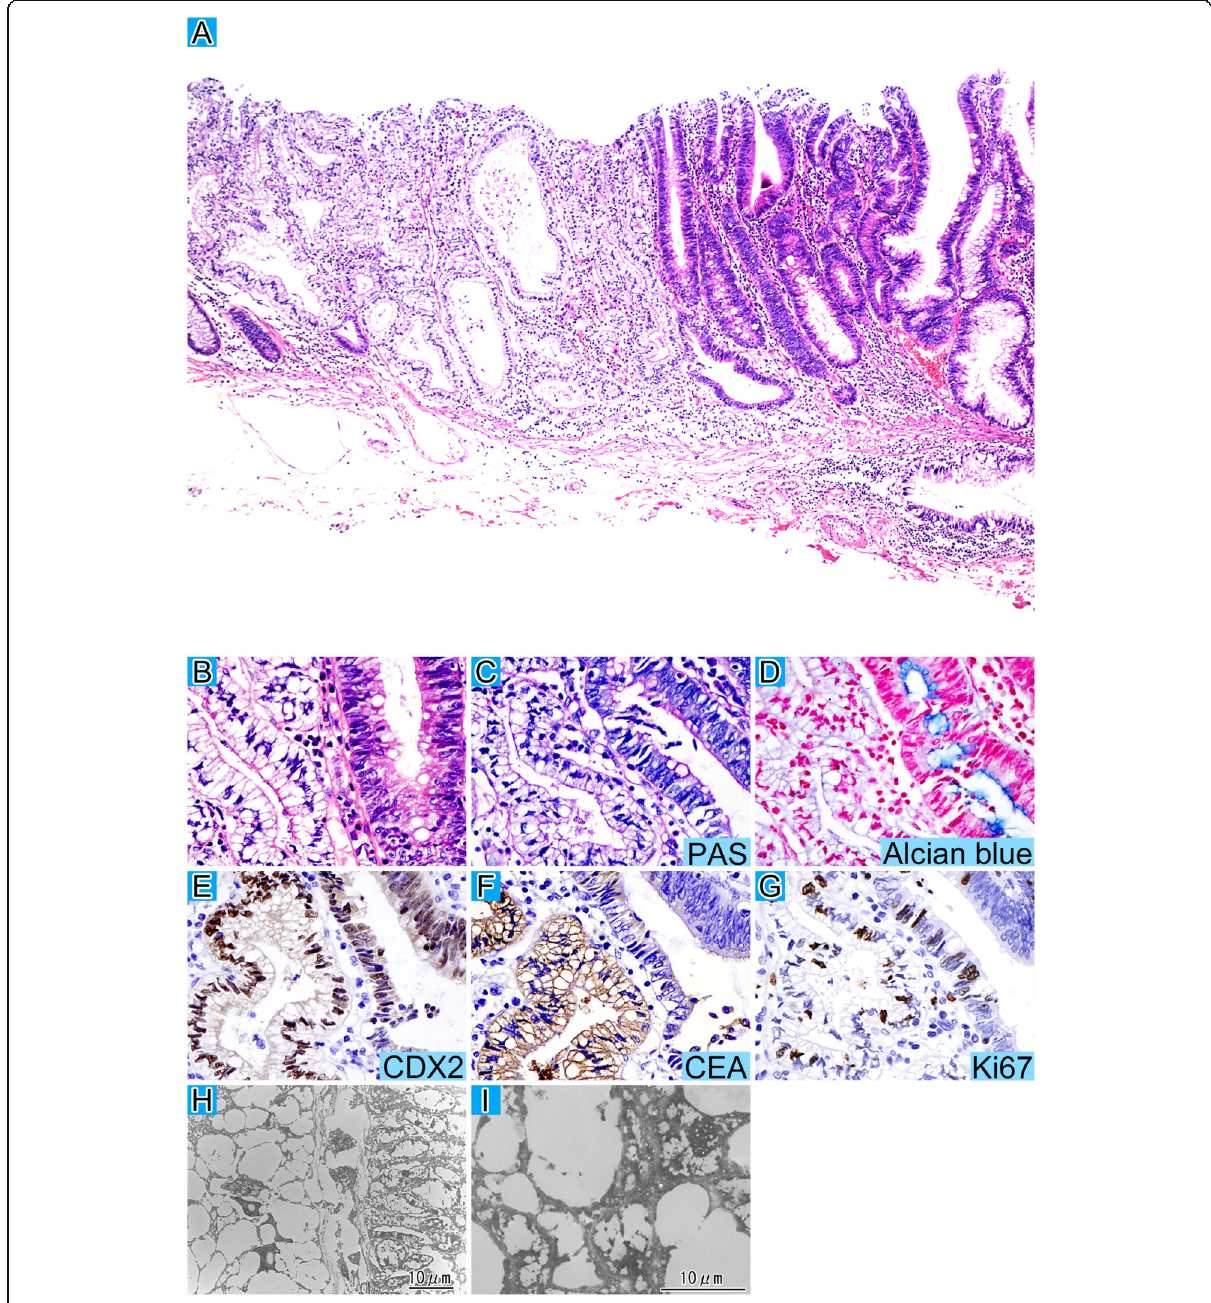
Fig. 1 Tubular adenoma with clear cell change. The striking tubule structures of the clear cells are accompanied by conventional tubular adenoma cells at low magnification with HE staining ( a ). The boundary between the clear cell and conventional components at high magnification with HE staining ( b ). The clear cell component is negative for PAS ( c ) and alcian blue staining ( d ). Both components are positive for CDX2 staining ( e ). The localization of CEA (f) expression is diffusely cytoplasmic for the clear cell component, and luminal cell apical for the conventional one. Ki67 labeling ( g ) is slightly lower in the clear cell component. d-g represent immunohistochemistry. Ultrastructural examination ( h ) of the boundary between the clear cell area (left) and the conventional adenoma (right) at low magnification is shown and multiple cytoplasmic lipid-like vacuoles surround the nuclei in the clear cells ( i